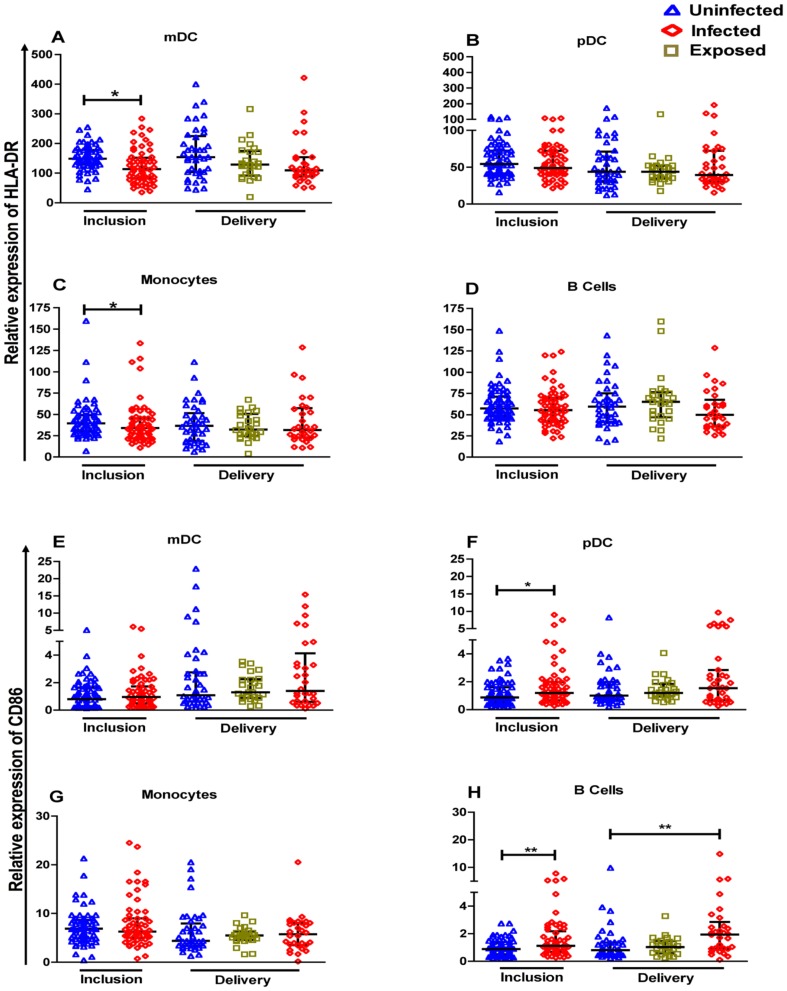

P. falciparum infection-related changes in activation status of antigen-presenting cells at inclusion and delivery in pregnant Beninese.Scatter plots include bars depicting medians with interquartile ranges of HLA-DR expression (A–D) and CD86 expression (E–H) on APC of 69 uninfected compared to 62 infected women at inclusion and of 47 uninfected, 27 exposed and 37 infected women at delivery. The statistical significance of differences in levels of expression were determined using the non-parametric Mann Whitney U test for data at inclusion combined with the Kruskall Wallis test for data at delivery. *p<0.05, **p<0.01, ***p<0.001.